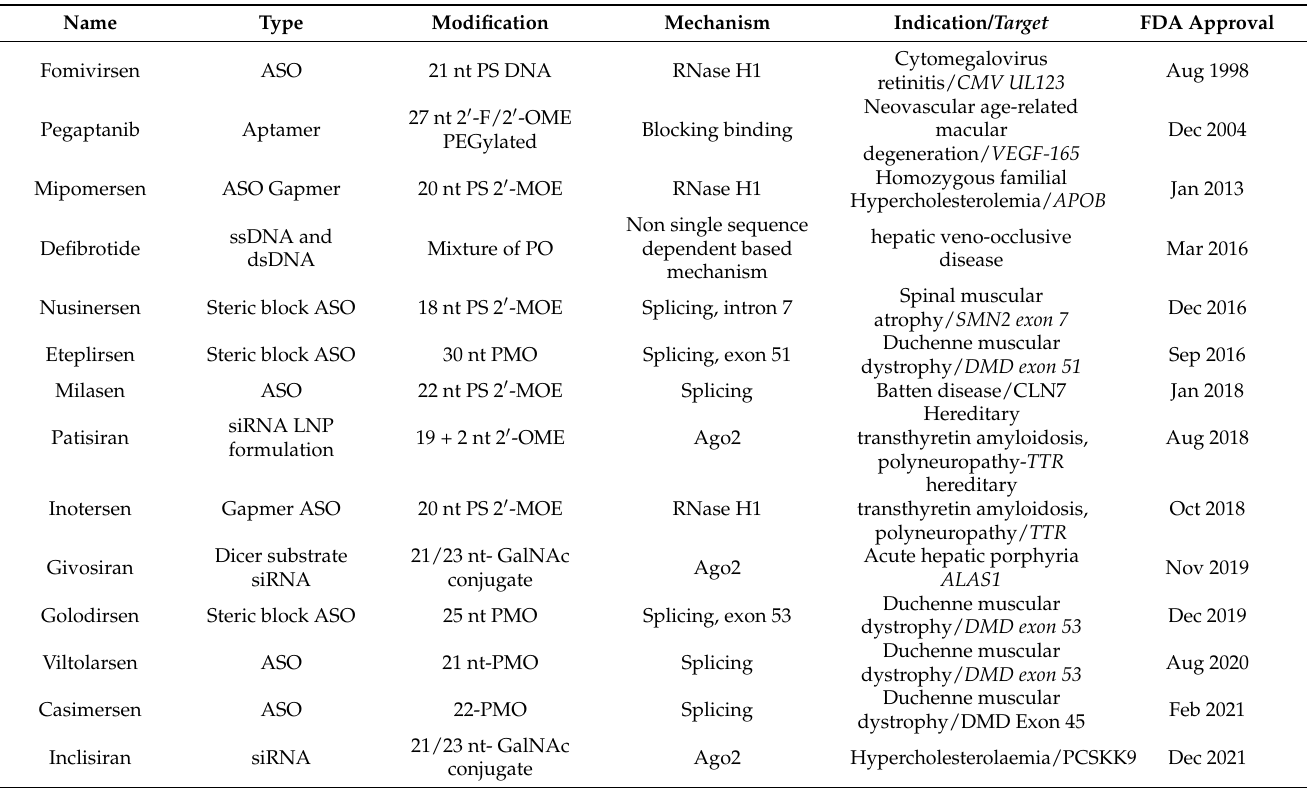
Table 1. List of FDA approved oligonucleotide